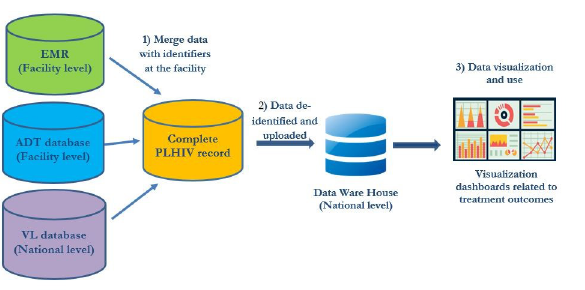
Fig 1. Data flow of the enhanced data system to monitor safety and efficacy of new optimized ARVs.